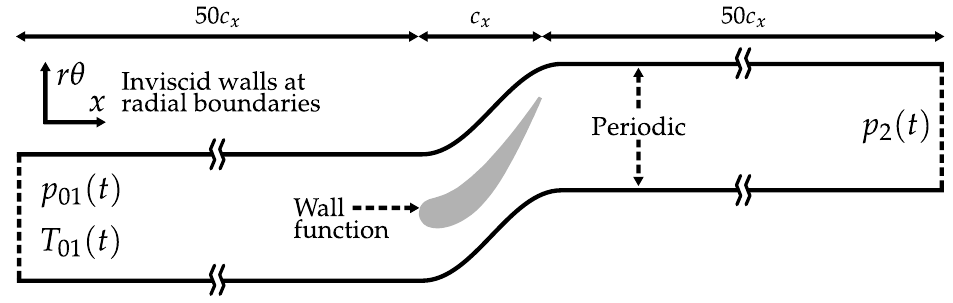
Figure 3. Domain and boundary conditions for computational fluid dynamics